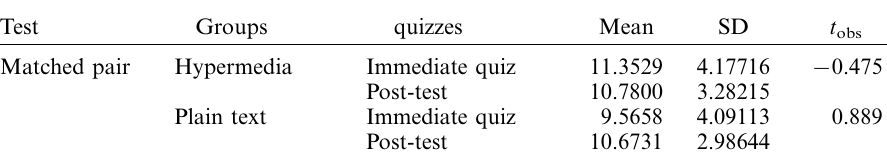
Table 5. Matched pairs: immediate quizzes and post-test.